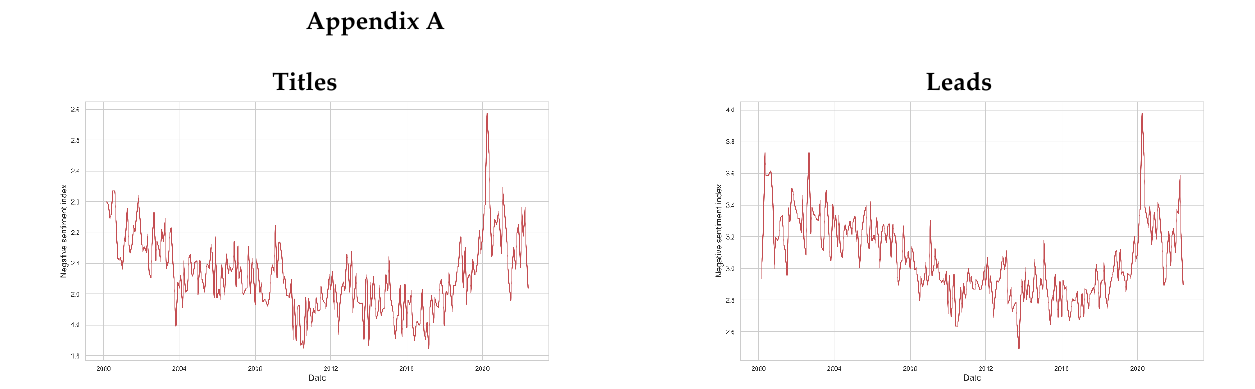
Figure A1. Sentiment analysis of news titles and leads over time for overall news.